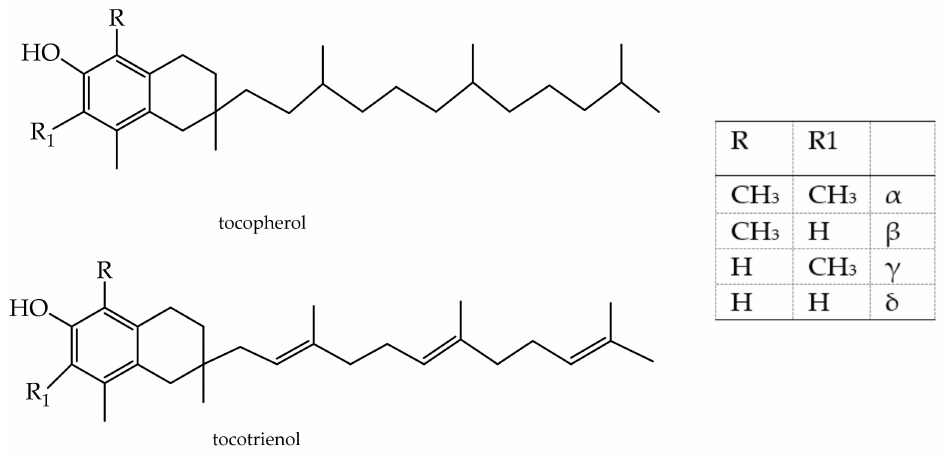
Figure 4. Tocopherol and